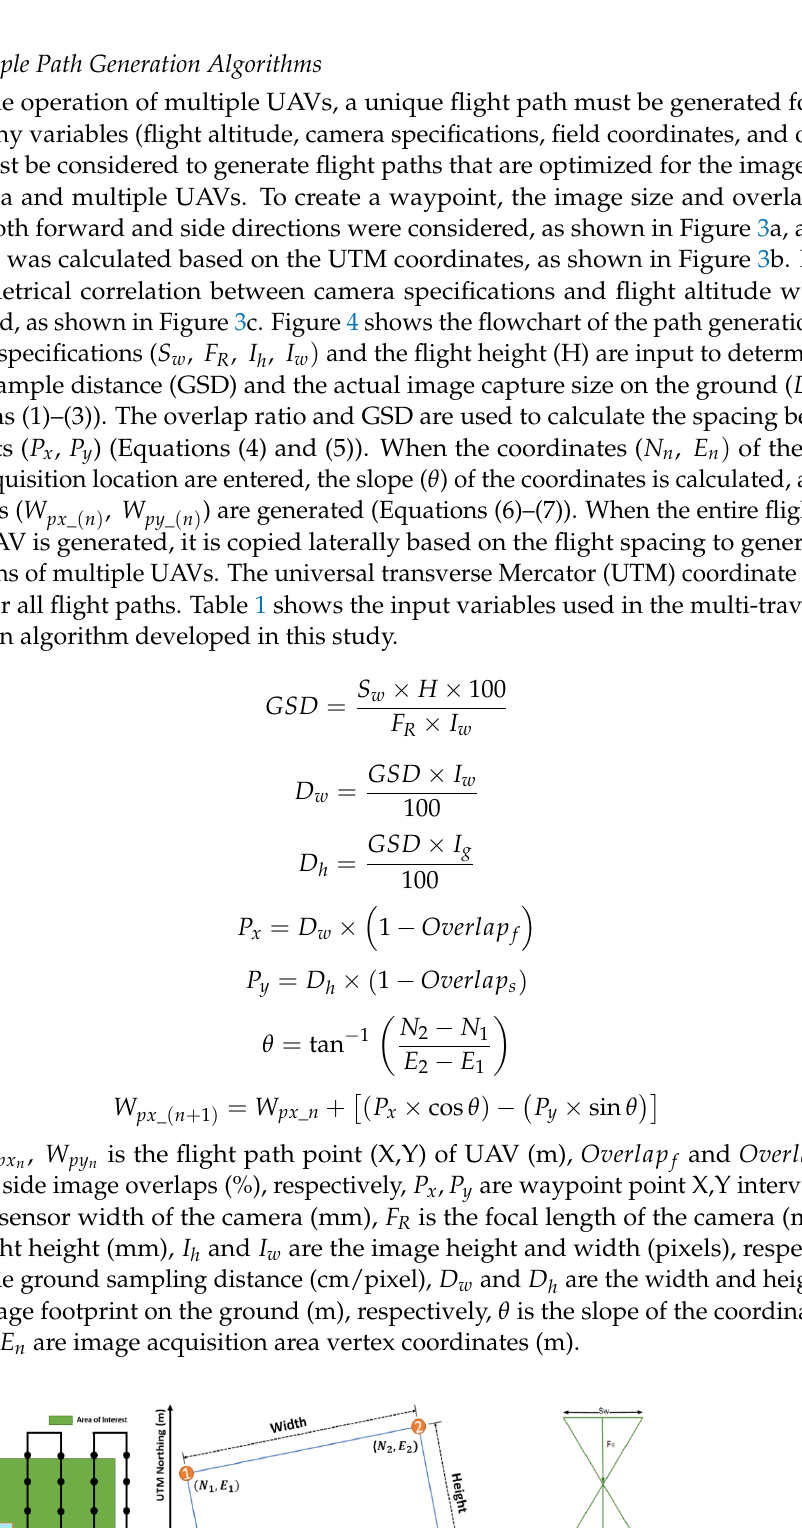
Figure 4. Flowchart of the path generation algorithm for the collaborative driving system. Table 1. Input variables required for path generation. Input Variables